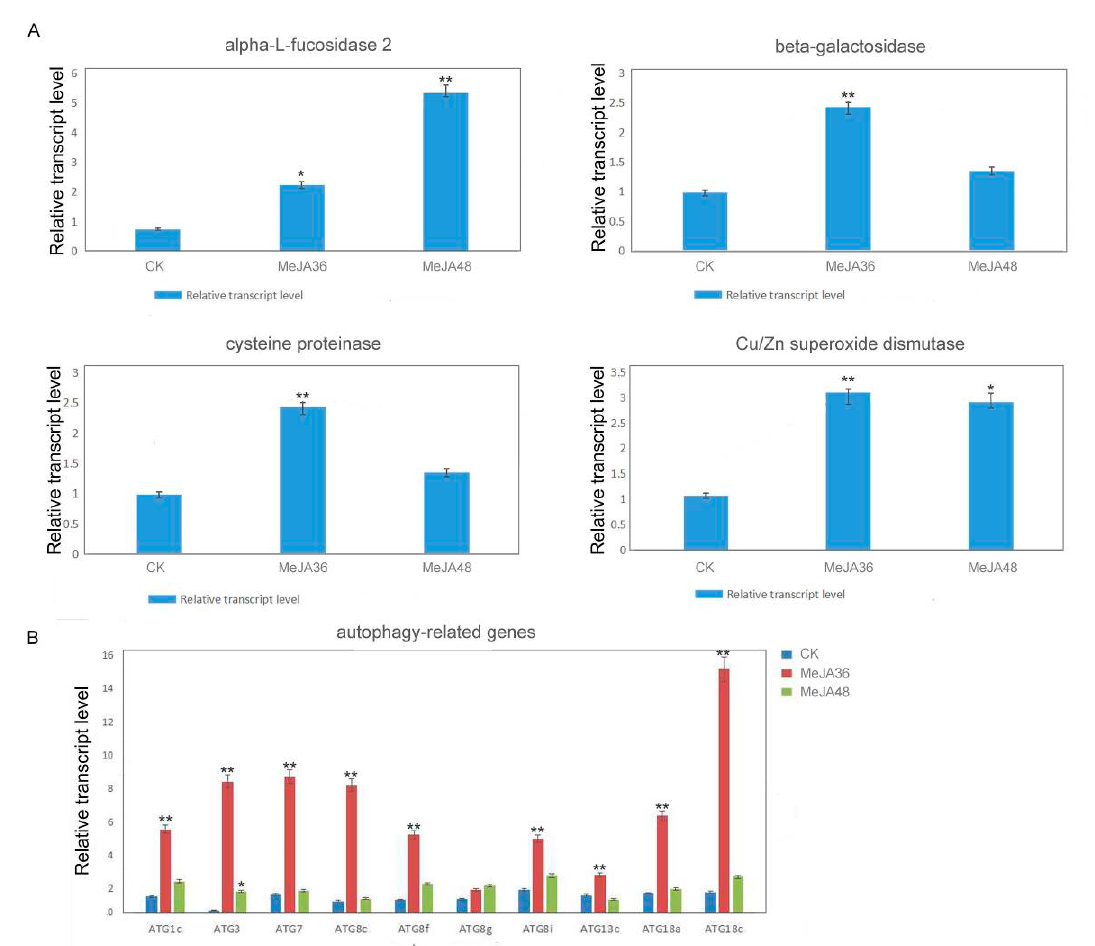
Figure 4. Transcriptional expression was significantly enhanced after being treated with Methyl jasmonate (MeJA). ( A ) qRT-PCR analysis of the transcription levels of selected genes that were significantly differentially expressed in latex proteomics. ( B ) Time-course gene expression profile of selected autophagy genes. “*” and “**” indicate statistically significant ( p -value ≤ 0.05 or p -value ≤ 0.01 versus control groups), measured by the Student t test.